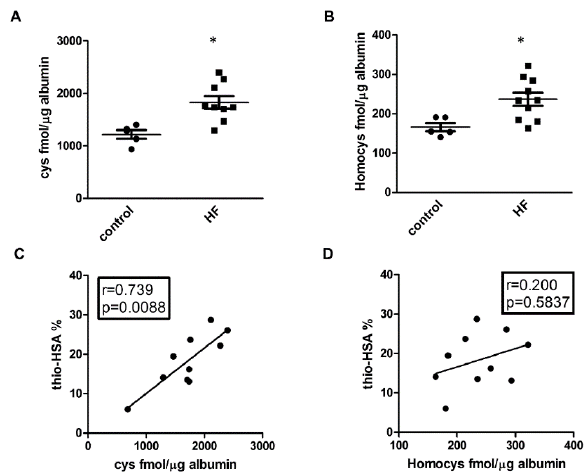
Figure 2. Identificationoflow-molecular-weightthiolsboundtoalbumin. ( A , B )Quantificationofcysteines bound to HSA (cys) and homocysteines bound to HSA (Homocys). * p < 0.05 vs. control. ( C , D ) Correlation between S-thiolated albumin (thio-HSA%) and cysteines or homocysteines bound to HSA.